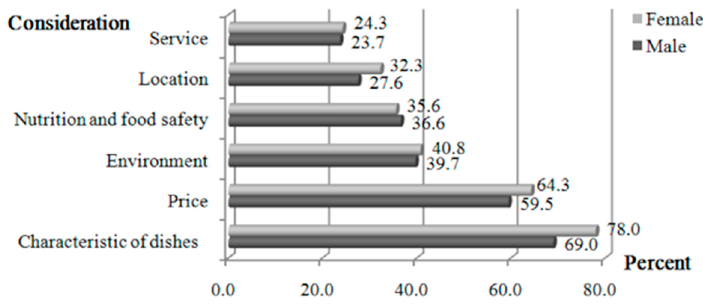
Figure 1. What are you thinking about when you can choose restaurant?